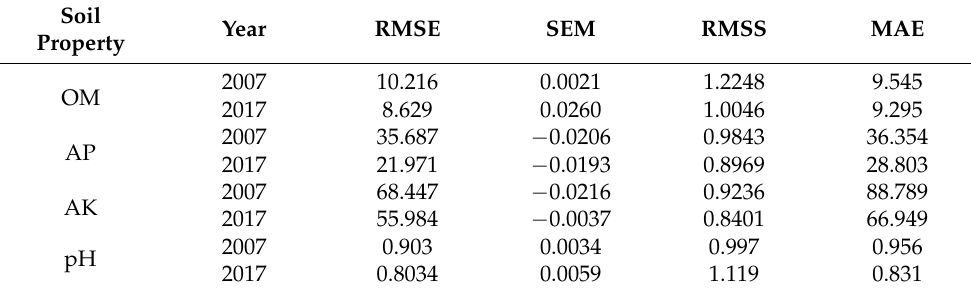
Table 1. Accuracy of soil data interpolation in Hefeng